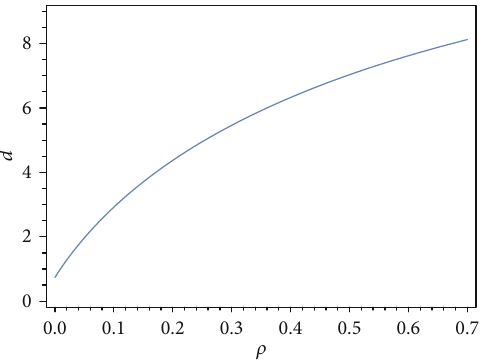
Figure 3: Sensitivity of d ∗ with respect to ρ .